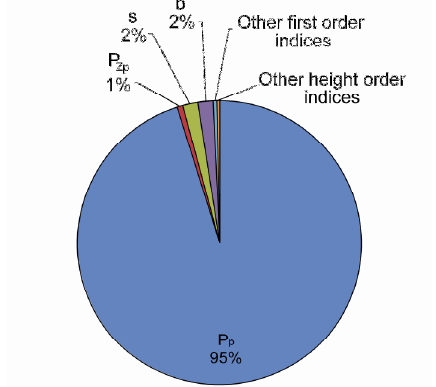
Fig. 14. Results for the second terrace